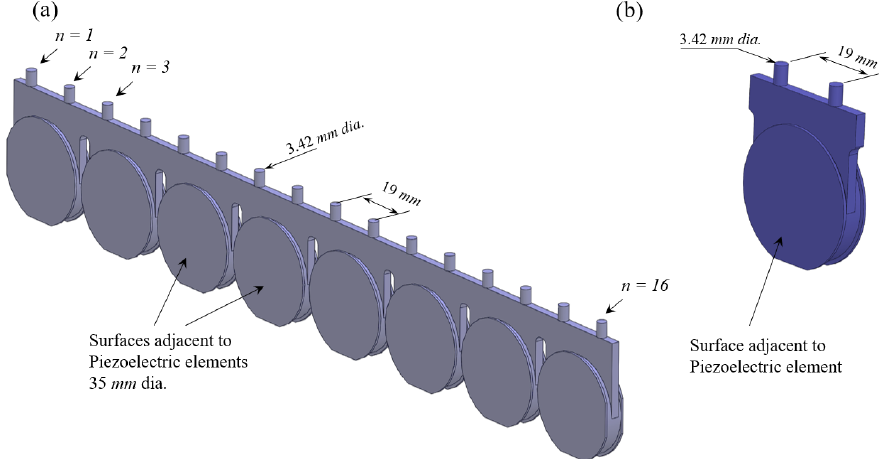
Figure 1. Exploded view of the SJA showing ( a ) the single cavity case, with 16 piezoelectric elements and 16 orifices, and ( b ) 8 single ‐ compartmented cavities, where the cavity volume plate illustrates how the division of the array cavity into 8 equal compartments is achieved. Dashed lines show the Each of the sixteen orifices have a diameter of 3.42 mm and the spacing between the orifices assembly lines. is 19 mm (centre-to-centre).